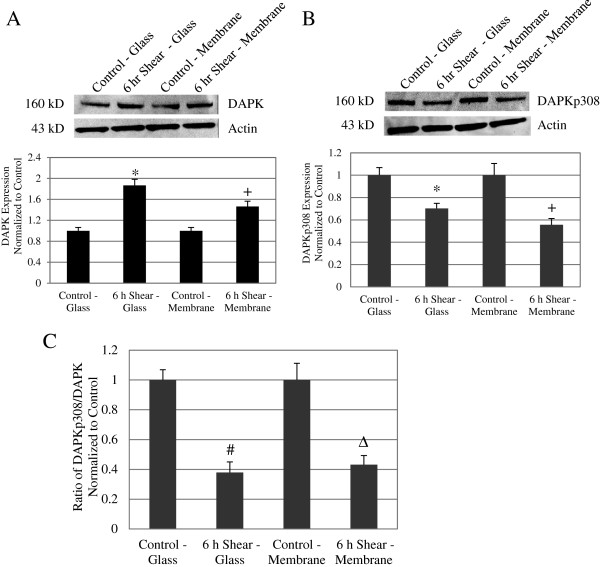
Shear stress decreased DAPK phosphorylation at serine 308 on glass and membrane substrates. (A) Western blot of overall DAPK expression in control and sheared cells (6 hours). Loading control bands are probed with anti-actin antibody on the same blot. DAPK expression increased with extended shear (Top). Quantitative analysis of band intensities was carried out on at least 4 separate sample sets. DAPK expression relative to actin is presented in the panel below as fold increase over control cells, for both glass and membrane samples. For both glass and membrane, DAPK expression increased with extended shear (Bottom). Data represent average ± standard error (n = 4) with * P < 0.01 compared to control-glass cells and + P < 0.05 compared to control-membrane cells. (B) Western blot of phosphorylated DAPK at serine 308, for control and sheared cells (6 hours). Loading control bands are probed with anti-actin antibody on the same blot (Top). Quantitative analysis of phospho-serine DAPK expression as fold increase over control, showed a decrease in phosphorylated DAPK serine 308 with 6hr shear, for both glass and membrane substrates (Bottom). Data represent average ± standard error (n = 4) with * P < 0.01 compared to control-glass cells and + P < 0.05 compared to control-membrane cells. (C) Phosphorylated DAPK as a fraction of total DAPK expression was calculated for each sample group based Western blot analysis. Compared to control cells, the fraction of phosphorylated DAPK decreased to a minimum of 38% for glass and 43% for membrane after 6 hours of shear stress. Data represent average ± standard error for 4 independent experiments (n = 4). # P < 0.01 compared to control-glass and Δ P < 0.01 compared to control-membrane.